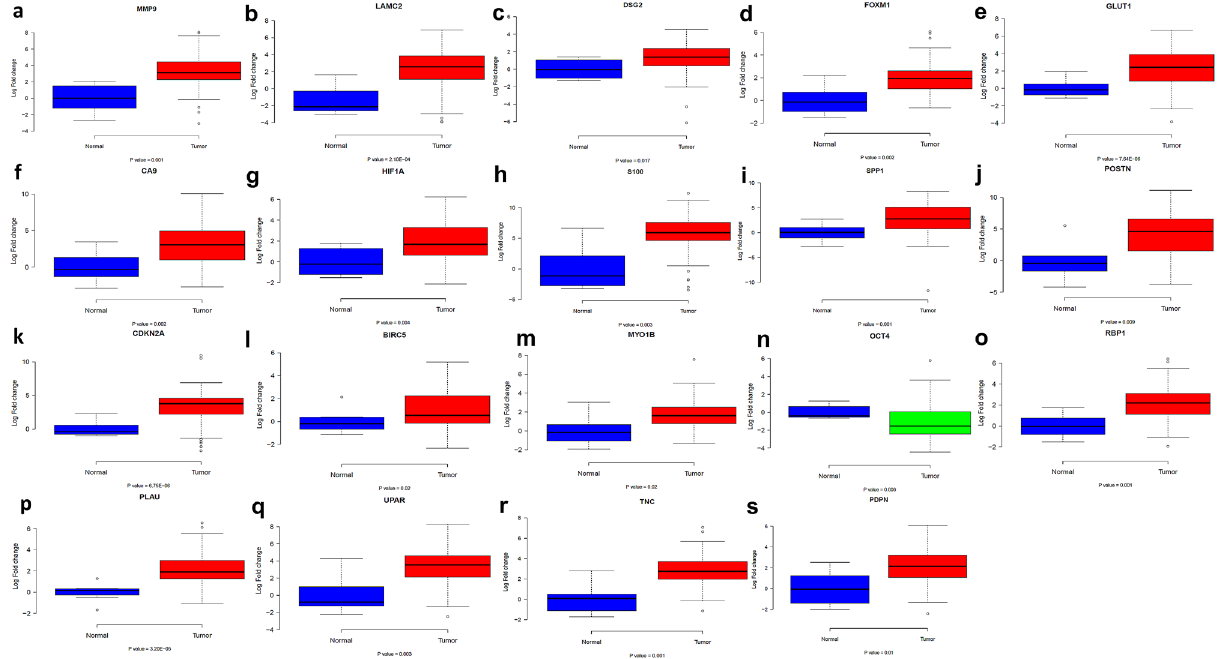
Figure 1. Box plot comparing the expression of genes in absolute normal tongue and OTSCC samples. Average log 2 fold change from tumor and adjacent normal samples have been compared and the P value from an unpaired t test is indicated in the figure. ( a ) MMP9 ( P = 0.001) ( b ) LAMC2 ( P = 2.10e−04) ( c ) DSG2 ( P = 0.017) ( d ) FOXM1 ( P = 0.002) ( e ) GLUT1 ( P = 7.64e−06) ( f ) CA9 ( P = 0.002) ( g ) HIF1A ( P = 0.004) ( h ) S100 ( P = 0.003) ( i ) SPP1 ( P = 0.001) ( j ) POSTN ( P = 0.009) ( k ) CDKN2A ( P = 6.75e−06) ( l ) BIRC5 ( P = 0.001) ( m ) MYO1B ( P = 0.02) ( n ) OCT4 ( P = 0.006) ( o ) RBP1 ( P = 0.001) ( p ) PLAU ( P = 3.20 e−05) ( q ) UPAR ( P = 0.003) ( r ) TNC ( P = 0.001) ( s ) PDPN ( P =